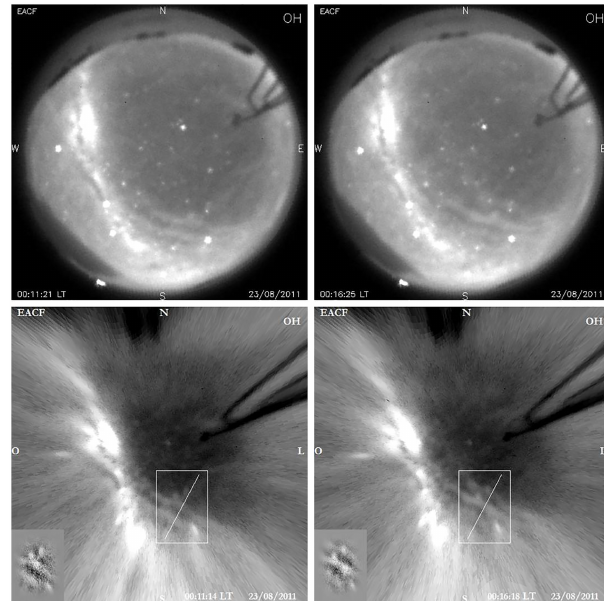
Figure 1. Original airglow images (a) and unwarped images (b) used for the spectral analysis of the gravity waves. This meso- spheric front was observed on 8 May and characterized with images from 07:15 to 07:23UT. The lower panels show the images with the star field removed and a small region used for analysis (selected white box), already filtered by a high-pass filter.